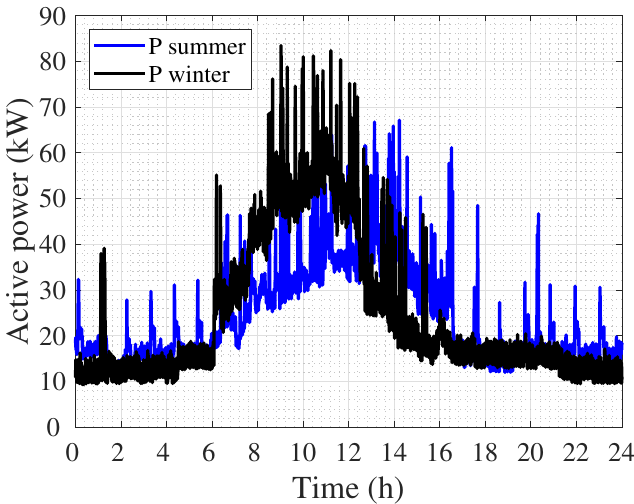
Figure 7. Industrial consumption profiles for summer and winter scenarios.